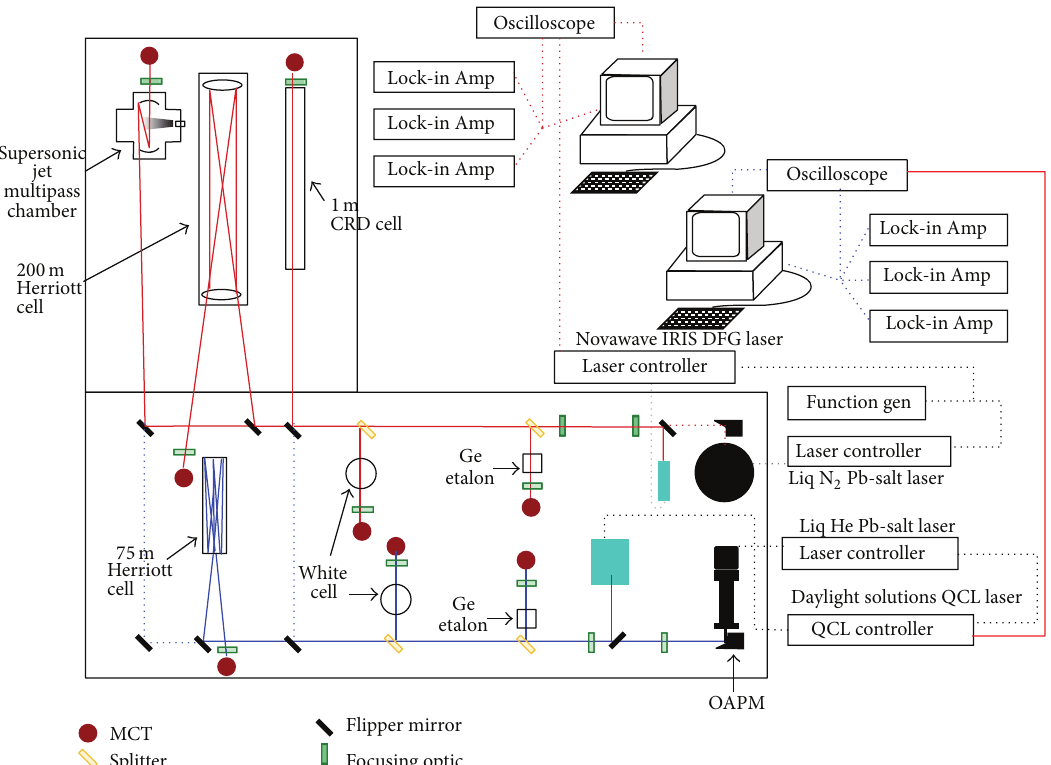
Figure 1: ArCLAS infrared system for determining spectroscopic signatures. There are numerous infrared light sources available including Pb-salt diode lasers, a Novawave DFG laser designed for operation near 3 microns, and four Daylight Solutions cw QCL lasers designed for operation at 10.6, 7.5, 5.5, and 4.5 microns, respectively.